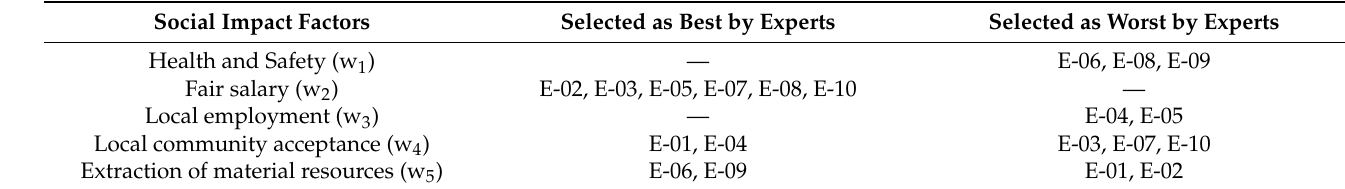
Table 5. Best and Worst criteria for the steel